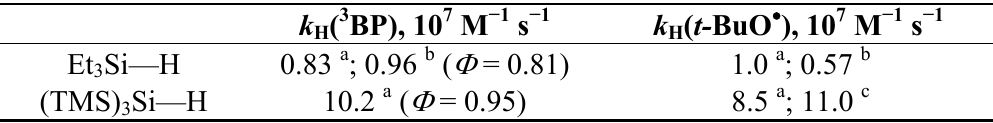
Table 1. Rate constants for the hydrogen abstraction from silanes by 3 BP and t- BuO  at 25 °C (  , ketyl radical quantum